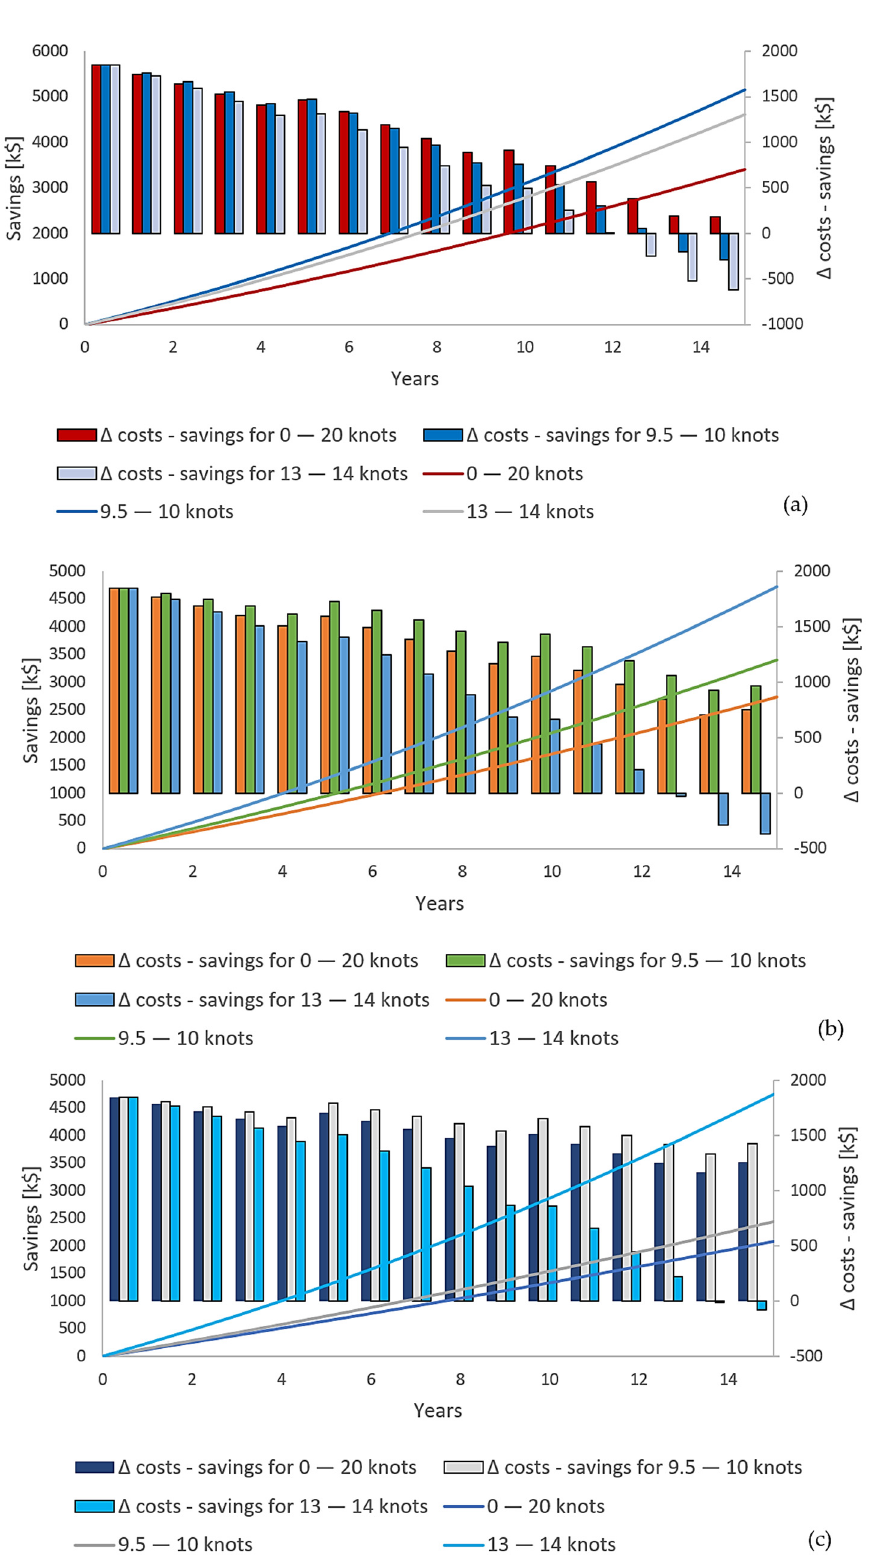
Figure 16. 6DOF simulation for a route from Barcelona to Alexandria in different rotor configura- tions: ( a ) D = 5 m and AR = 6; ( b ) D = 3 m and AR = 8; ( c ) D = 3 m and AR = 6.